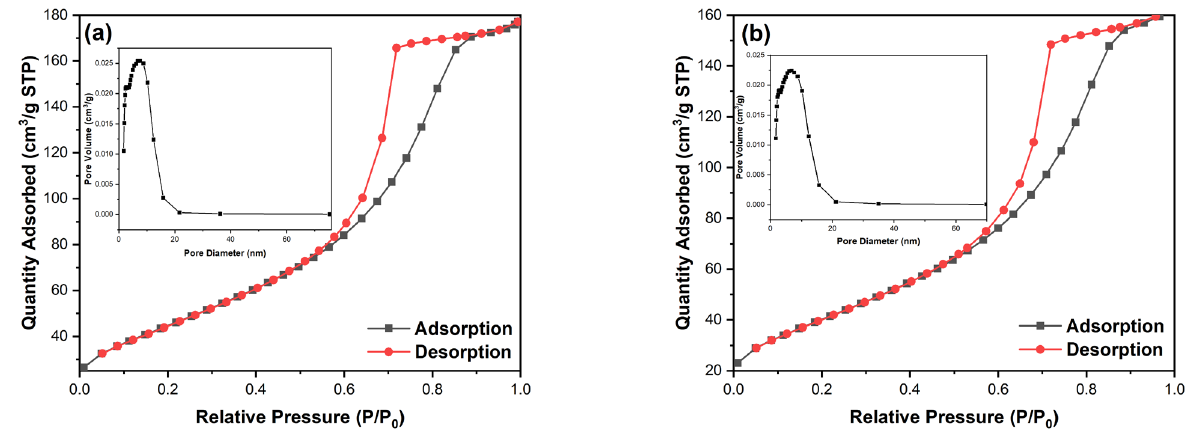
Figure 5. Nitrogen adsorption–desorption isotherms and pore size distribution curves of ( a ) pure TiO 2 and ( b ) 4%Ag-TiO 2 .